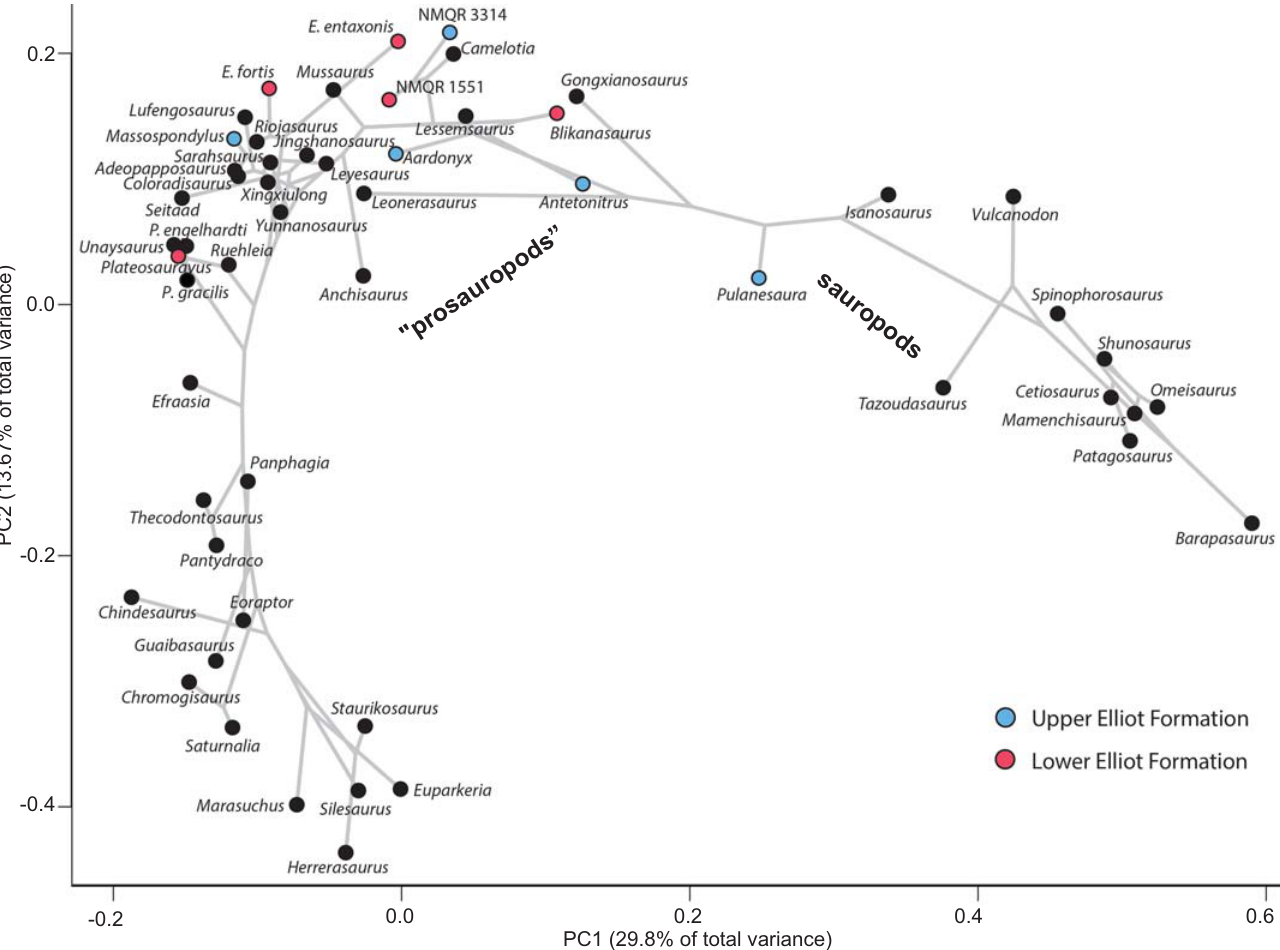
Fig. 8. Morphospace plot of the first two PCO axes generated in the R statistical environment (Claddis package). Branches are superimposed from a single representative topology selected from amongst the 48